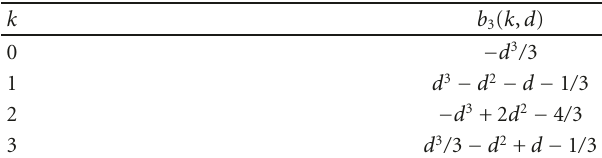
Table 2: Filter coe ffi cients for the fourth-order B-spline bandlim- ited step function (BLEP) algorithm as a function of the fractional delay d